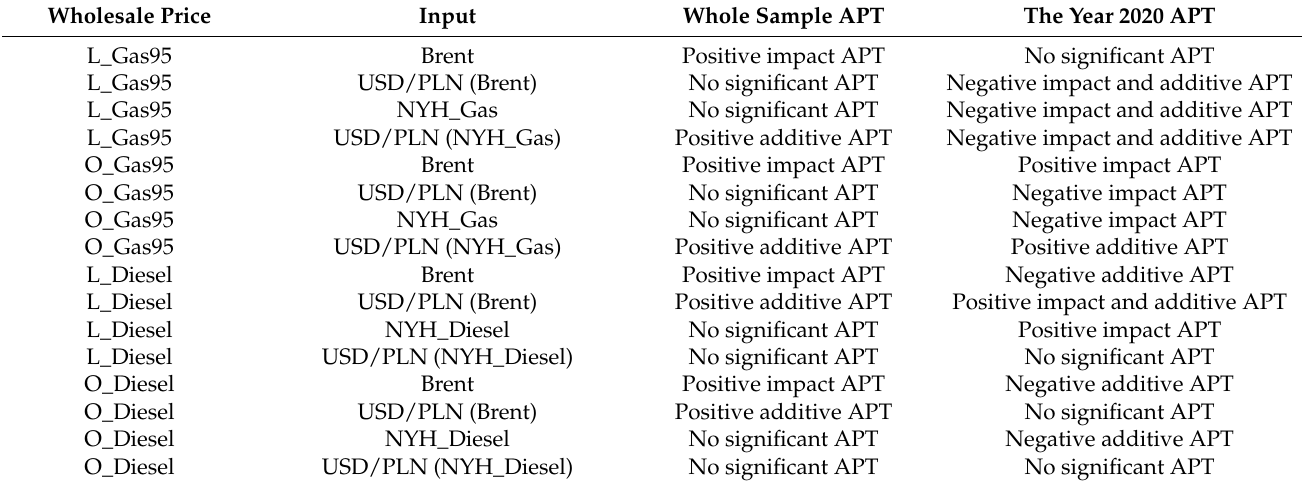
Table 9. Comparison of the effects of impact and short-run APT—whole sample and 2020 subsample. Wholesale